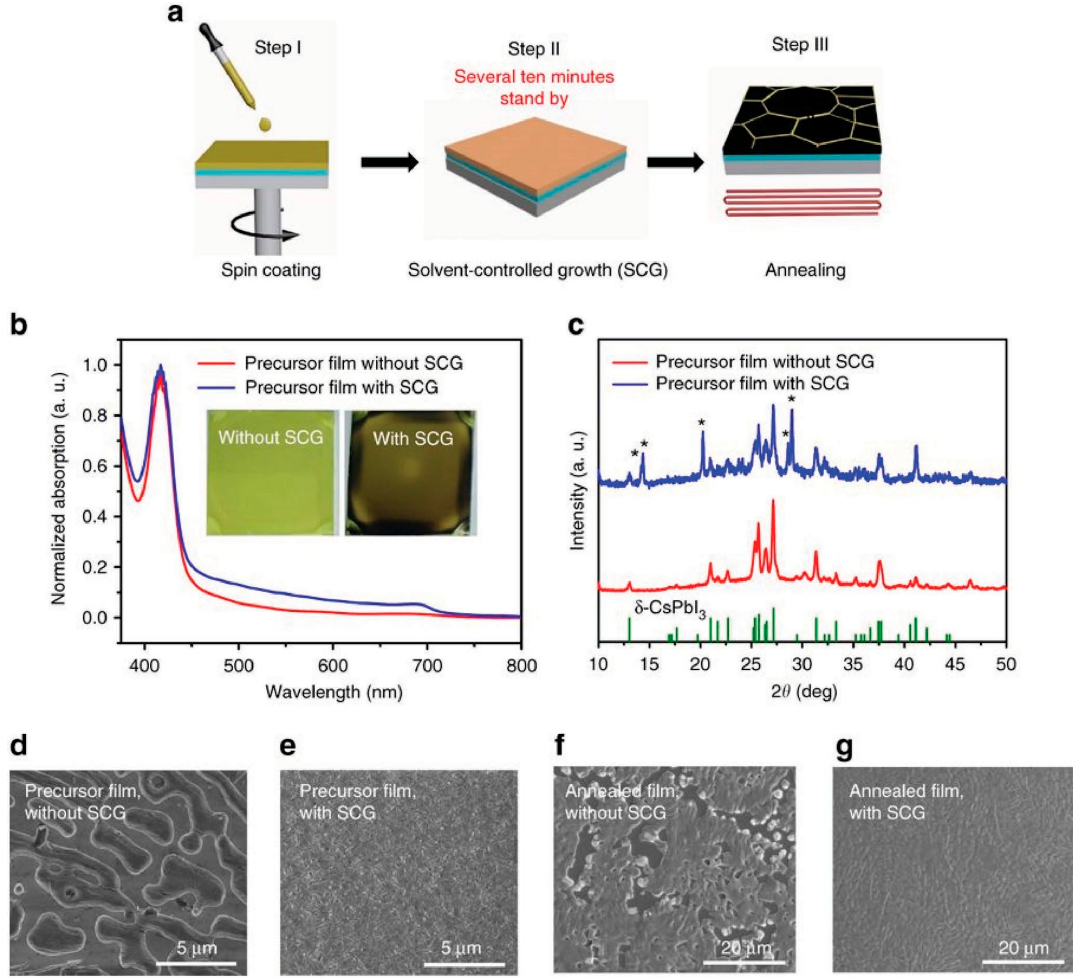
Figure 2. Solvent-controlled growth (SCG) technique for depositing CsPbI 3 thin film: ( a ) Illustration of film preparation; ( b ) Plots showing normalized absorption spectra of CsPbI 3 films without and with SCG technique, whereas inset depicts the as-prepared films images without and with SCG; ( c ) X-ray-diffraction plot of the as-prepared CsPbI 3 film—the peaks dominantly shoot from δ -phase CsPbI 3 without the SCG technique. A certain amount of the δ - phase CsPbI 3 has been converted into the β -phase post SCG application. The peaks distinguished with “*” marks originate from β -phase CsPbI 3 ; ( d , e ) Scanning electron microscope snapshots of the as-prepared CsPbI 3 films without and with SCG, respectively, and ( f , g ) Scanning electron microscope snapshots of annealed CsPb I3 films without and with SCG, respectively. Adapted with permission from [42].